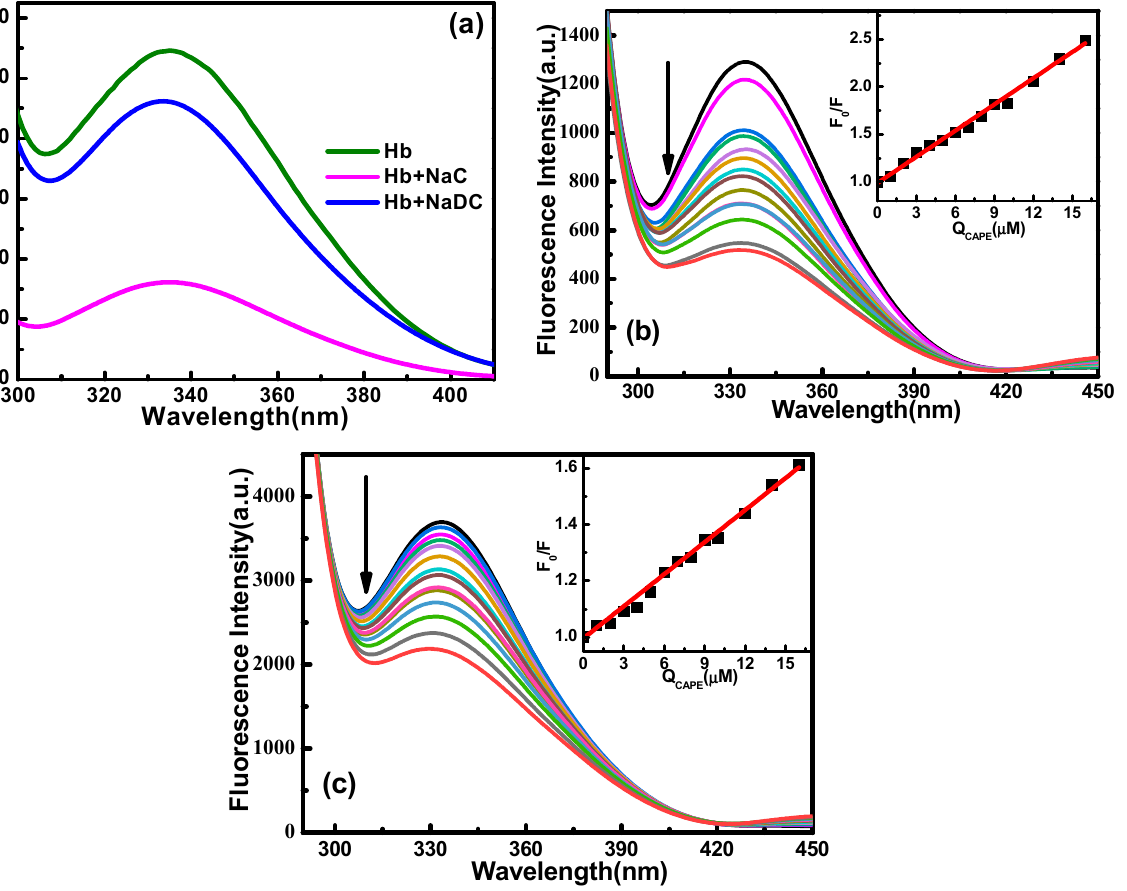
Figure 4. Fluorescence spectra of Hb for different systems at 298.2 K and in pH 7.4 phosphate buffer solution: ( a ) Surfactant–Hb system; ( b ) NaC–CAPE–Hb system; ( c ) NaDC–CAPE–Hb system. The concentrations of NaC and NaDC are fixed at 3.3 mM and 2.5 mM. The concentrations of CAPE are 0, 1, 2, 3, 4, 5, 6, 7, 8, 9, 10, 12, 14 and 16 µM from top to bottom in direction of arrow. The insets in Figure 3b,c show the corresponding Stern–Volmer diagrams.